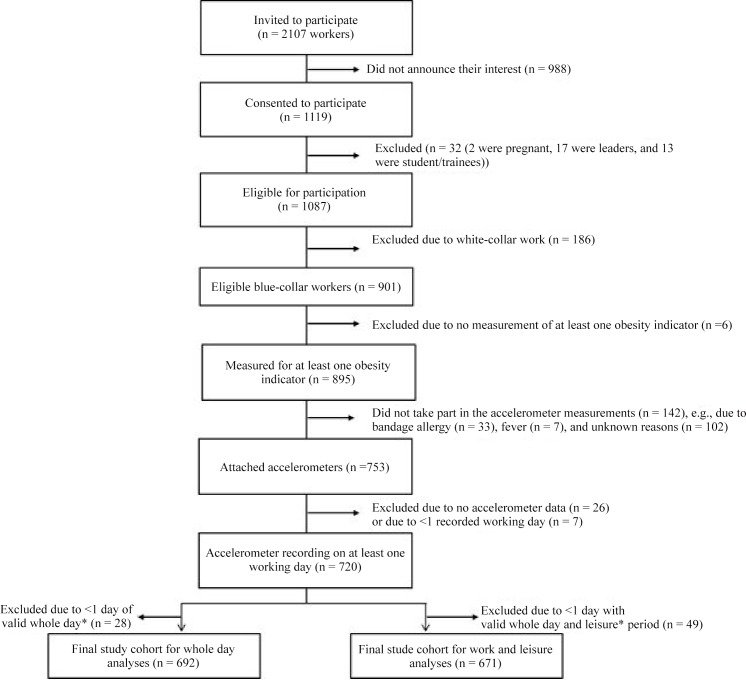
Recruitment flow of the study population.Note: *Valid whole day, work and non-work time are defined in the ‘Material and Methods’ section.